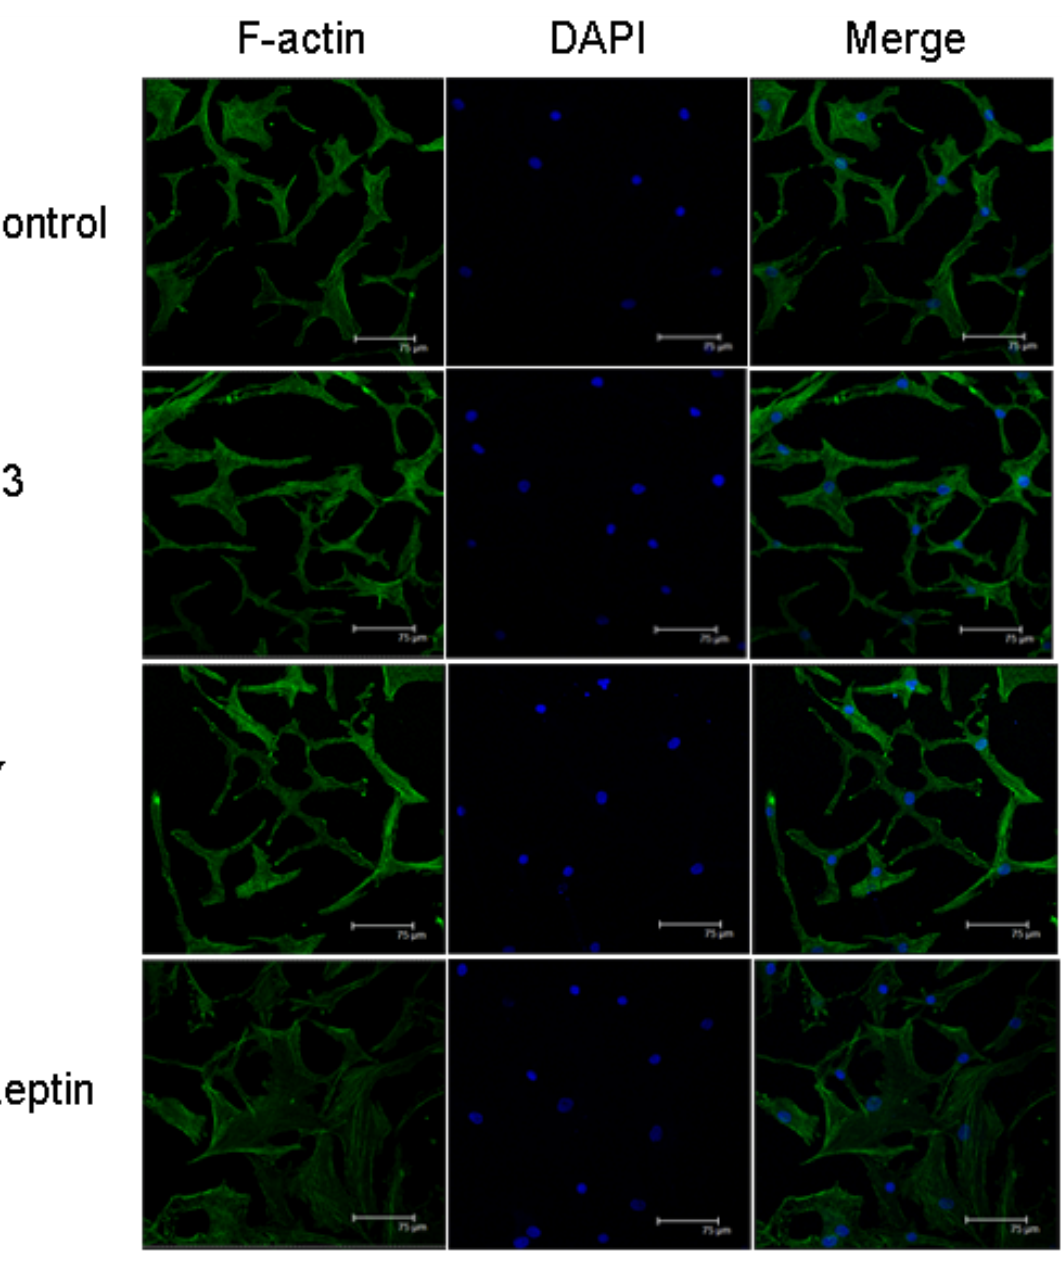
Figure 5. Pharmacological inhibitors of Rho and ROCK prevented F-actin remodeling in human NP cells treated with leptin. NP cells were treated with vehicle (control), specific C3 exoenzyme (C3), or Y-276320 (Y) and incubated in the presence or absence of leptin (10 ng/mL). Fluorescence microscopy images showing both C3 exoenzyme and Y-27632 inhibited leptin-induced actin cytoskeletal reorganization and actin stress fiber formation. Scale bars represent 75 μ